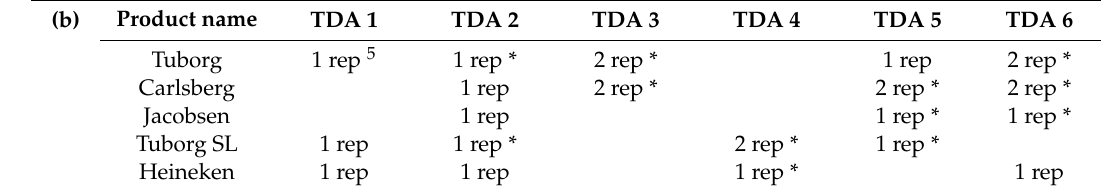
Table 1 for beer reference frame. 4 TDA = training descriptive analysis. The numbers refer to the TDA sessions 1–6. 5 Notions “1 rep” and “2 rep” indicate samples that were presented once or twice in a single training session. *